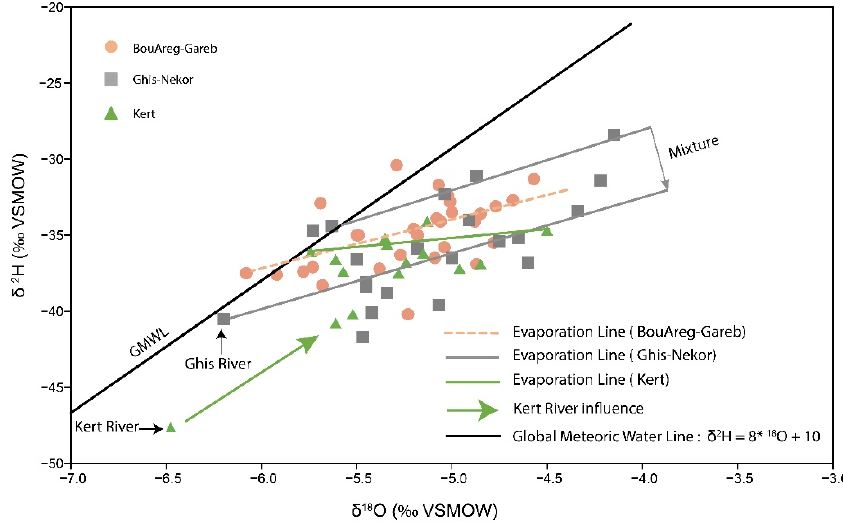
Figure 5. Isotope δ 2 H– δ 18 O compositions of the groundwater in the study areas. Table 1. Isotopes analysis ( δ 18 O, δ 2 H and δ 34 S SO4 and δ 18 O SO4 ), chemical analysis (sodium, chloride, sulfate, and nitrate) and electrical conductivity. S: Spring, R: Well near manure, GR: Ghis River, KR: Kert River, MM: Messinian Marls, C: Cinerite and VMD: volcanic marls